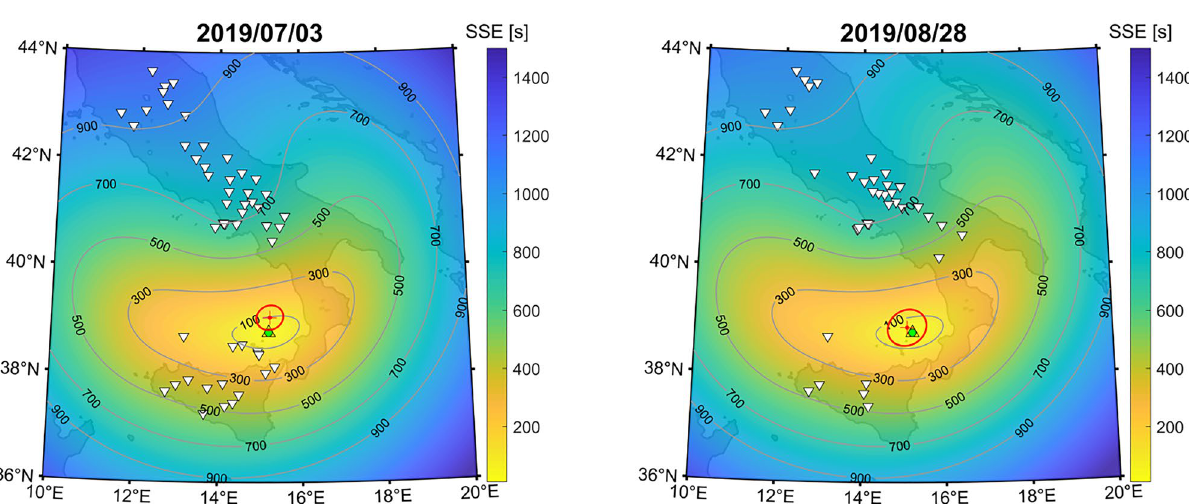
Figure 6. Geographical distribution of the time residuals for the July (left) and August (right) eruptions using the origin time given by the minimum of SSE. Grey curves are isocontours of SSE. White inverted triangles are selected seismic stations where clear signals from the eruptions (SNR > 10 dB) were observed (50 and 38 stations for the July and August eruptions, respectively). The red crosses indicate the centroid of cross-bearing location considering wind-corrected back-azimuths at stations IS26, IS37, IS42, IS48, AMT, OHP and CEA. The red ellipses show the 95% confidence. The map was generated using Matlab Mapping Toolbox Version 4.6 (https:// www. mathw orks. com/ produ